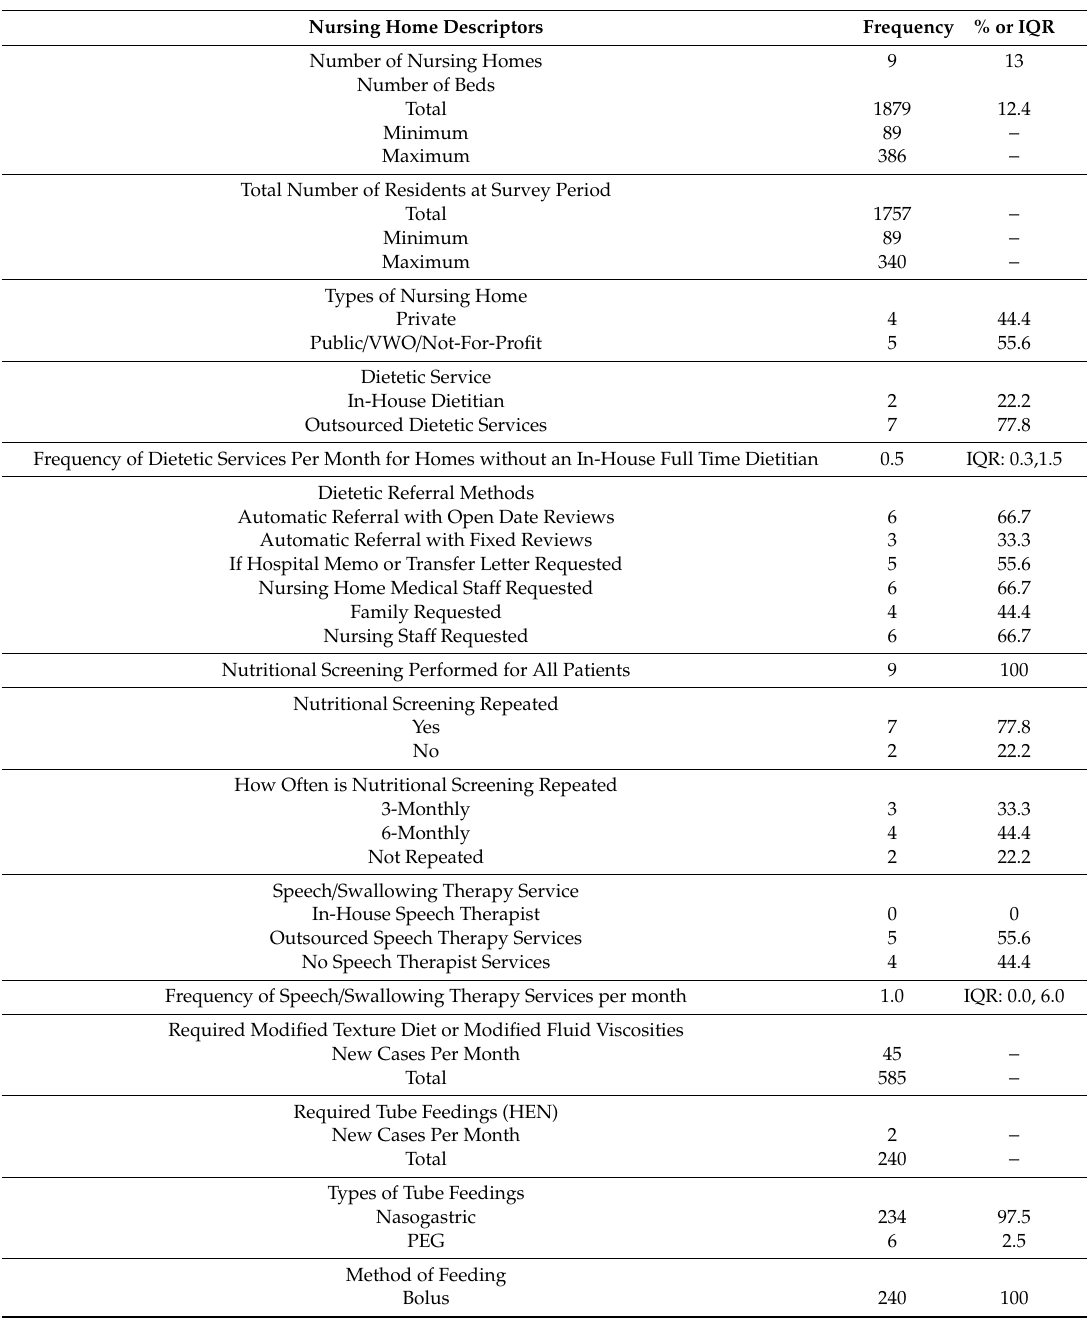
Table 1. Long-Term Care Facilities’